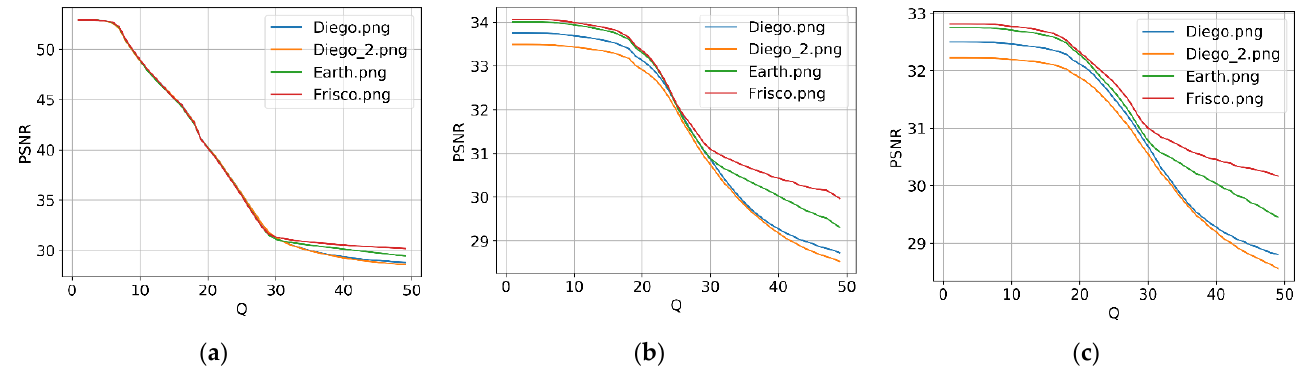
Figure 2. Dependencies PSNR nc ( Q ) for four considered three-channel images in formats 4:4:4 ( a ), 4:2:2 ( b ), and 4:2:0 ( c ).